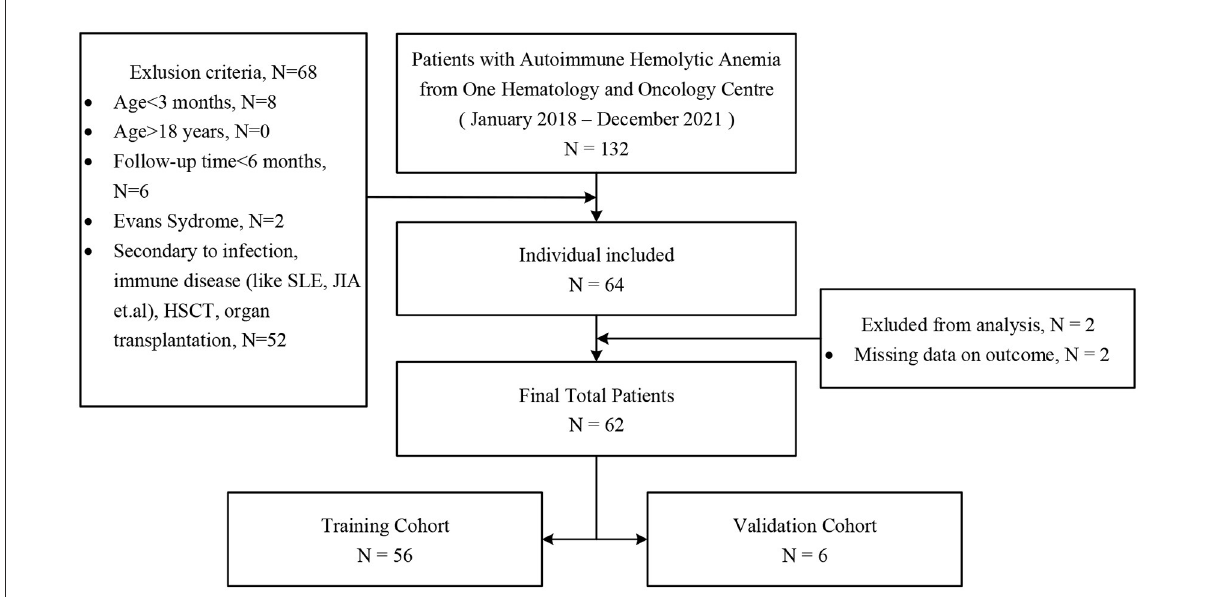
FIGURE1 Enrollment of patients for study groups. SLE, systemic lupus erythematosus; JIA, juvenile idiopathic arthritis; HSCT, hematopoietic stem cell